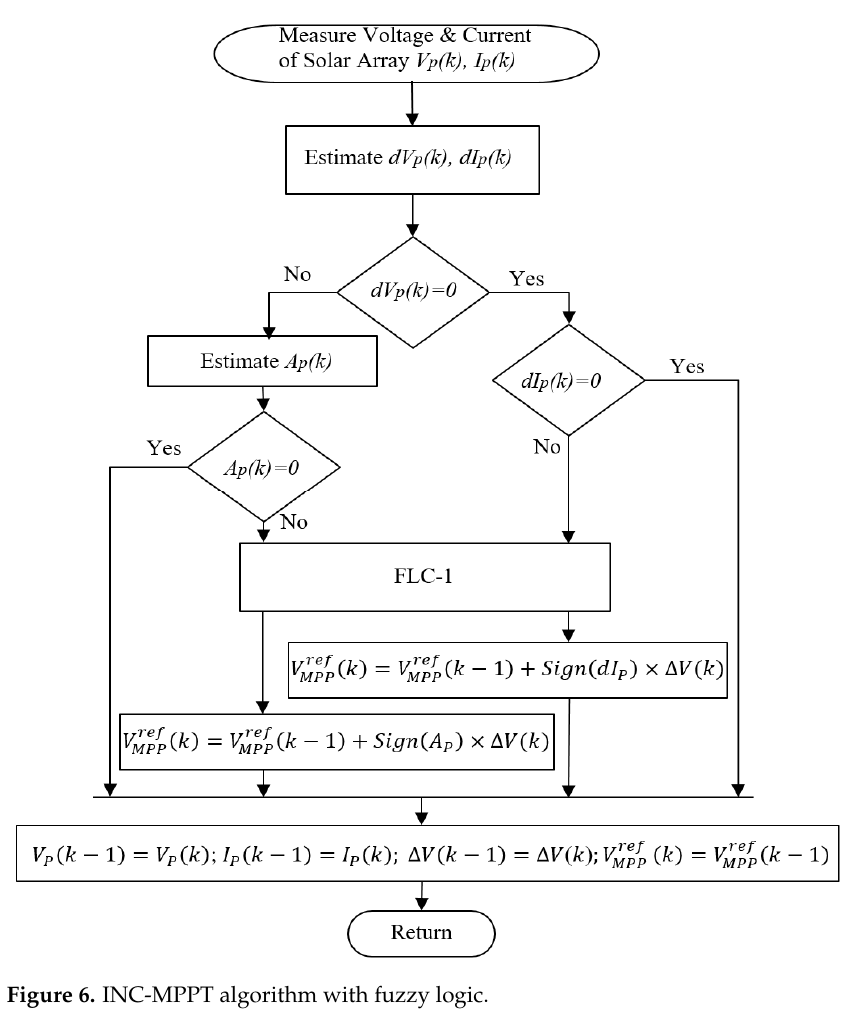
Figure 5. FLC-1 structure.